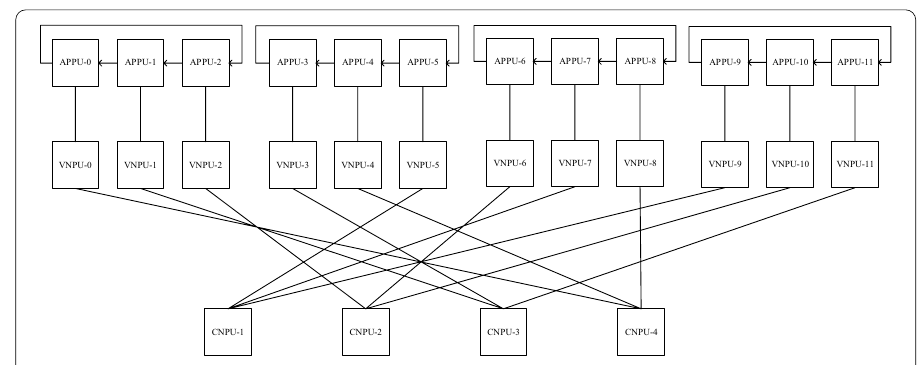
Fig. 6 LD architecture for shuffled PCM of Figure